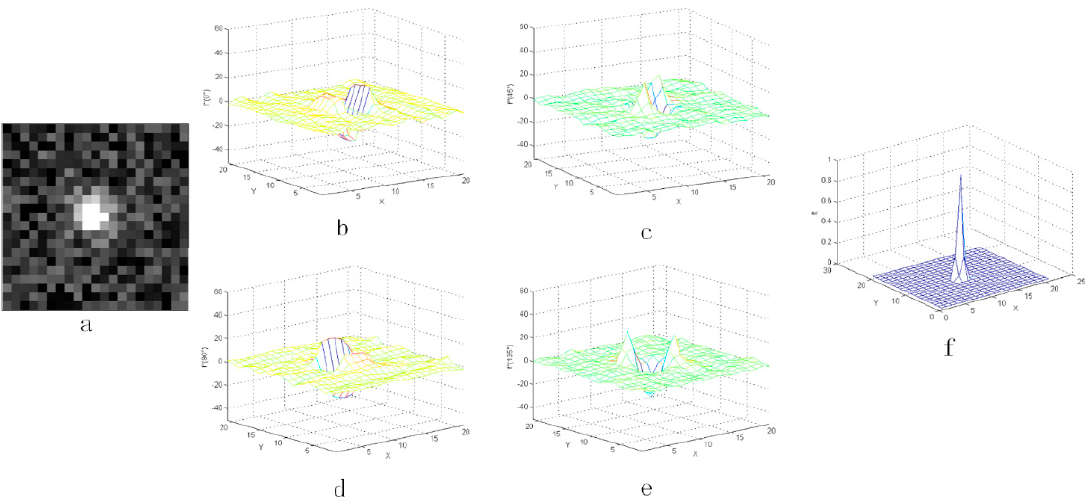
Figure 9. The result with the noise whose coefficient Q is 5%: ( a ) the star image with added random noise and ( b – e ) the three-dimensional distribution of the second-order derivative, ( f ) the output value f t after CMLCM processing.